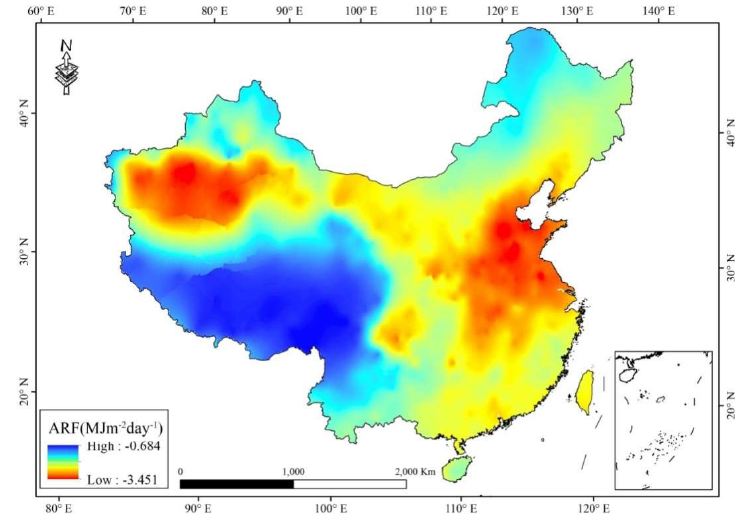
Figure 19. Distribution of the annual mean ARFB values over Mainland China during 1980–2015.